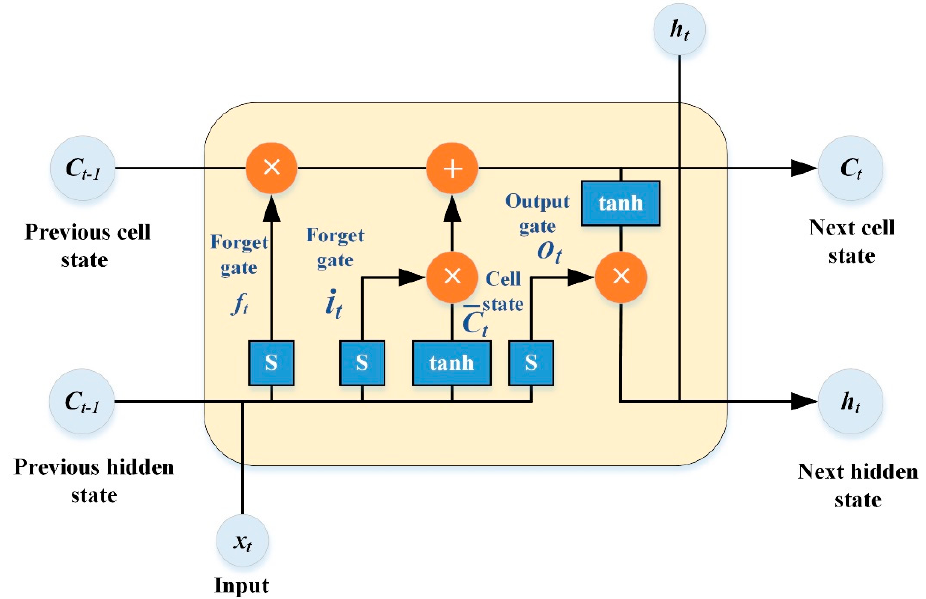
Figure 2. LSTM working schematic at time t .